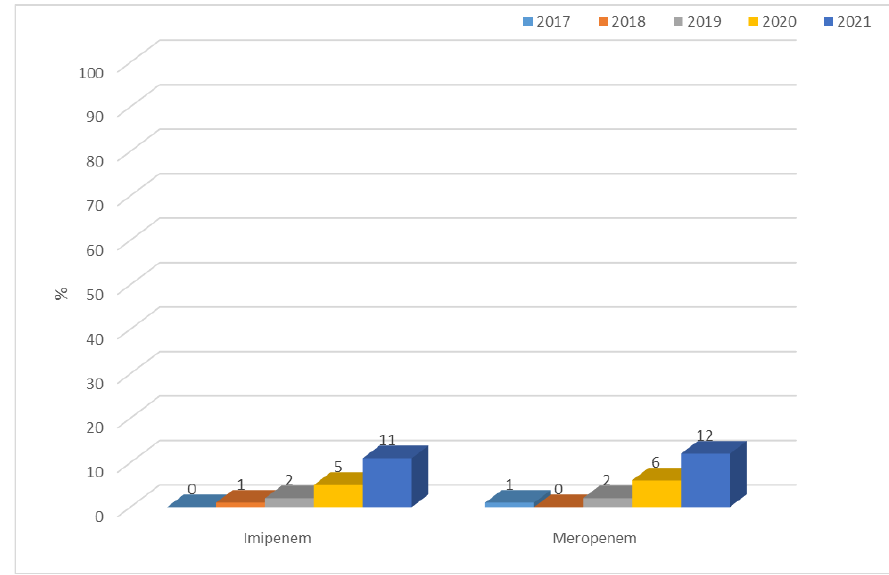
Figure 17. Percentage of K. pneumoniae strains resistant to carbapenems.